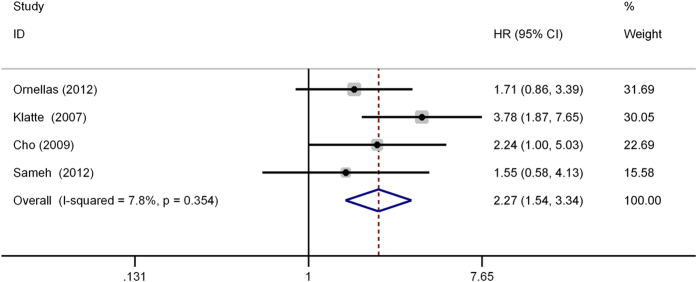
Forest plot of studies evaluating the association between urinary collecting system invasion and recurrence-free survival of renal cell carcinoma.HR = hazard ratio; CI = confidence interval.